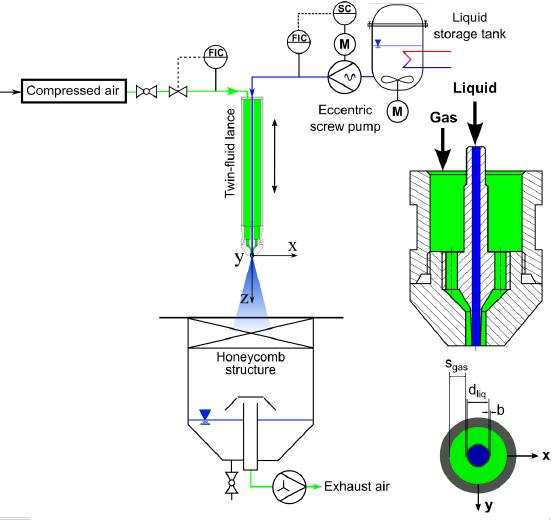
Figure 1. Schematic view of the atmospheric spray test rig (ATMO) with the applied twin-fluid